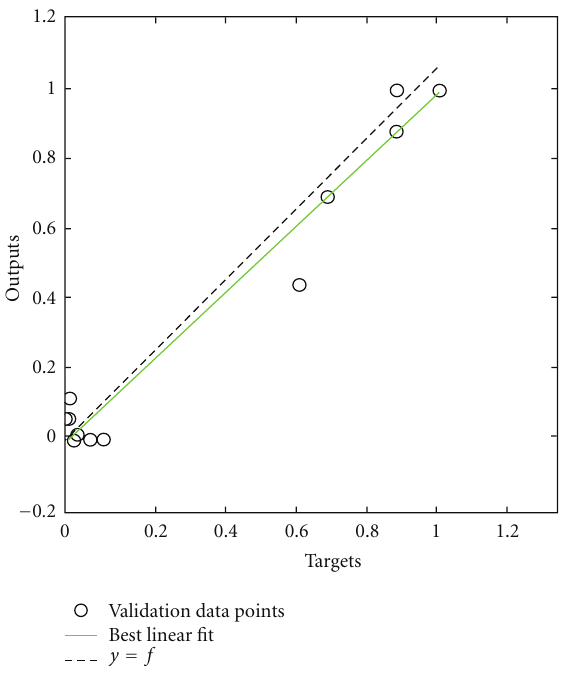
Figure 6: Testing outputs versus targets with correlation factor R = 0 . 89123.